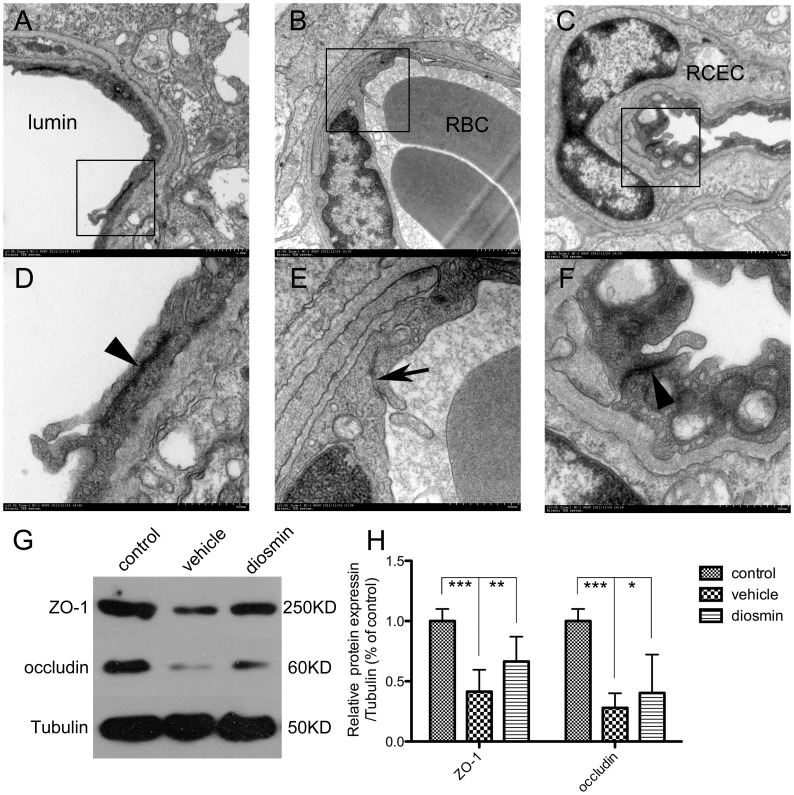
The ultrastructure of tight junctions (TJ) and the expression of TJ associated protein, ZO-1 and occludin.In control retinas (A, detail in D), the arrowhead shows “closed” tight junctions, which reflect the integrity of the TJ structure. Retinal ischemia induced “opened” tight junctions, as shown by the arrow in the vehicle groups (B, detail in E), indicating damage to the integrity of the TJ structure. Preserved “closed” tight junctions shown by the arrowhead after diosmin treatment (C, detail in F) indicated its protective effect on maintaining the integrity of the TJ structure after ischemic insult. A-C, magnification × 45,000; D-F, magnification × 150,000. (G) Representative Western blot showing the expression of ZO-1 and occludin. (H) Quantitative analysis of the Western blot. RBC, red blood cells; RCEC, retinal capillary endothelial cells. Data are expressed as the mean±SD (n = 6). *P<0.05, **P<0.01, ***P<0.001.